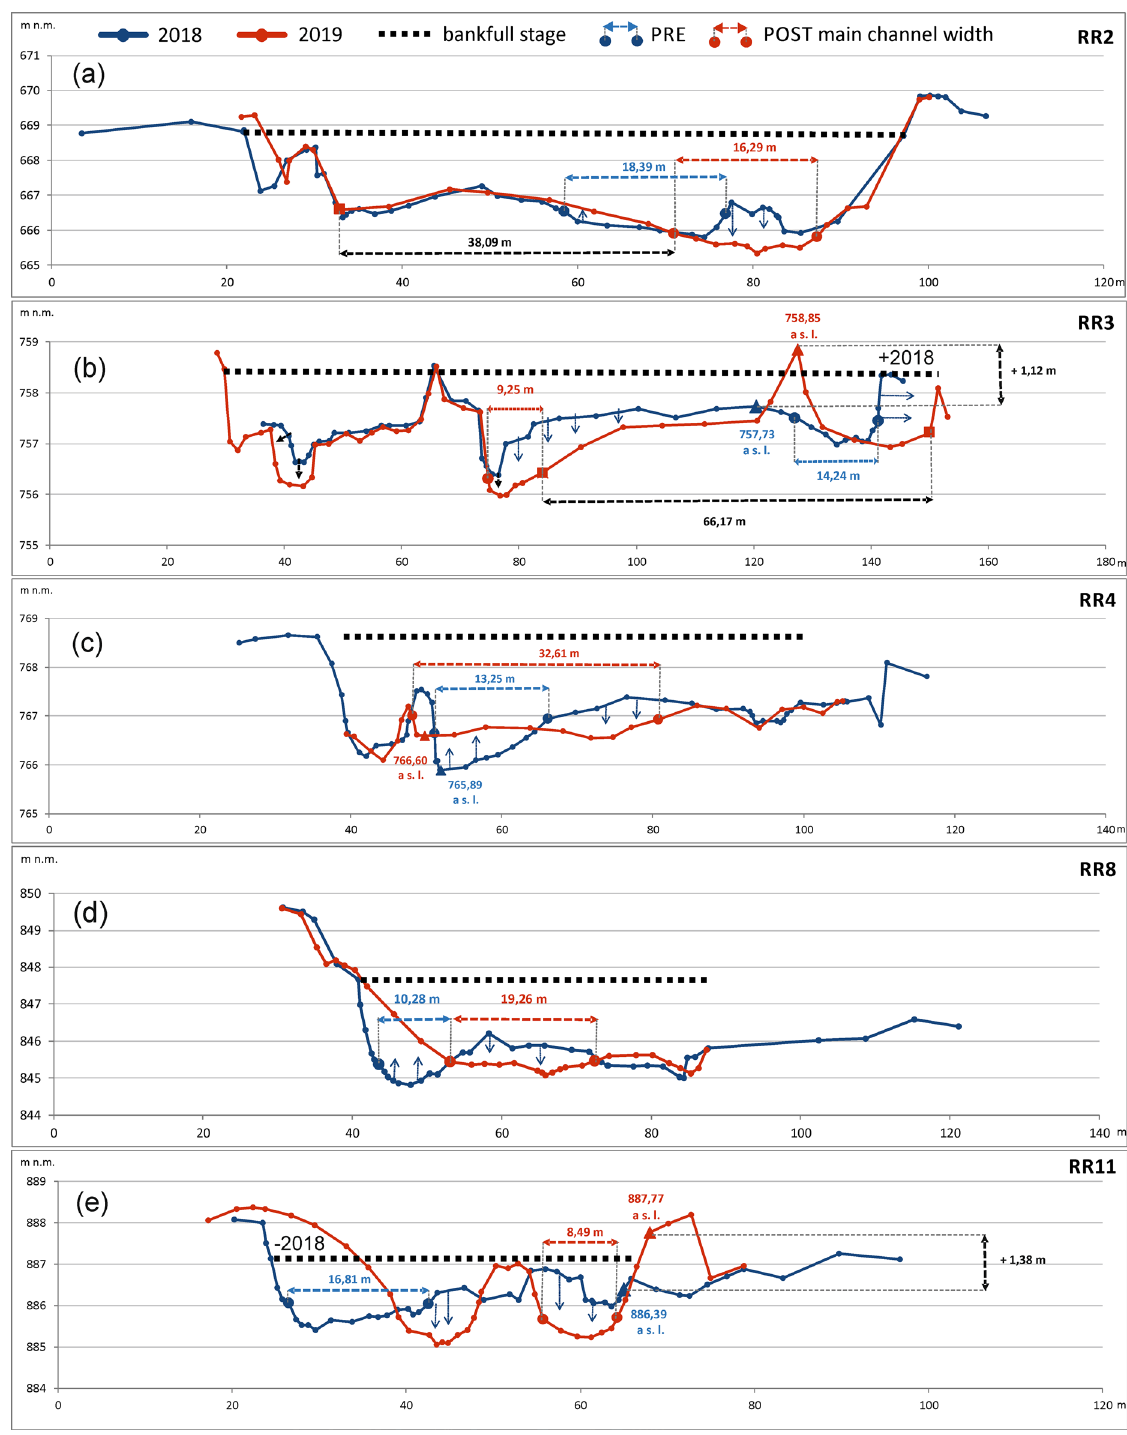
Figure 5. Geometry of cross-sections on the selected river reaches ( a ) RR2, ( b ) RR3, ( c ) RR4, ( d ) RR8, ( e ) RR11 on the Belá River where river training were carried out. The blue cross-section represents the reference state (PRE) of the river before the flood in July 2018; the red cross-section represents the state after this flood event and river training during August 2018 (POST). At each cross-section, the width of the main channel (m) is marked (red and blue numbers). Bankfull stage at each cross-section reflects measured bankfull width where value ± 2018 points out differences in width between pre- and post-flood management periods. The direction of the arrows marked in cross-sections represents surface modification of the river’s active zone during river